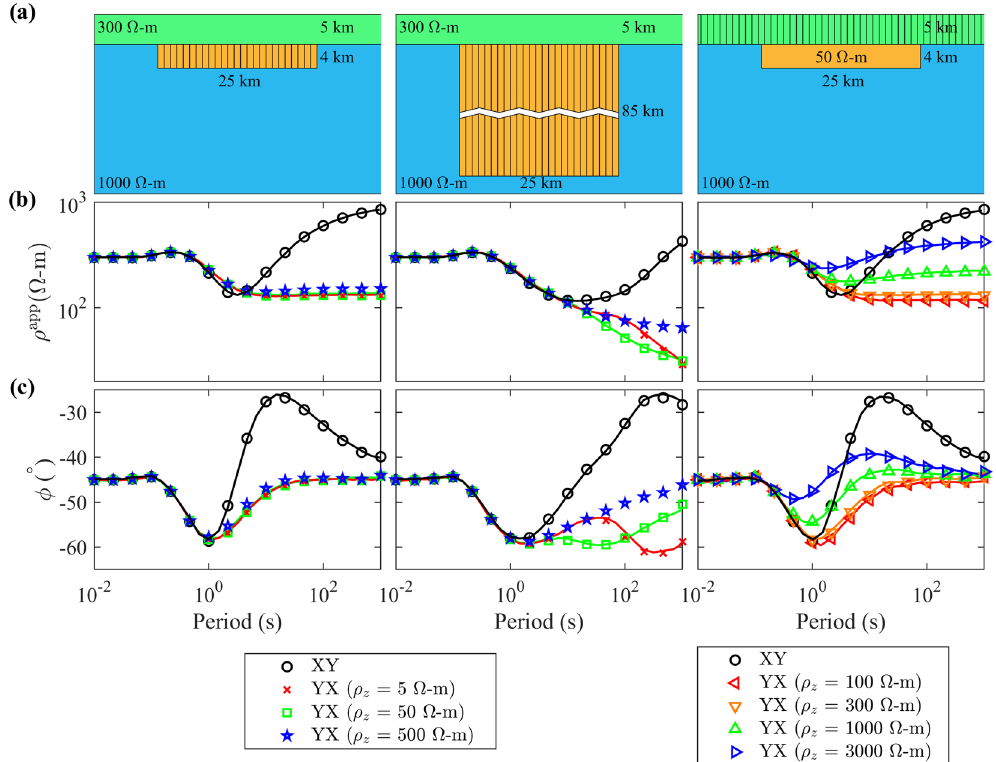
Fig. 14 a The three 2‑D synthetic models of Pek et al. (2008), b their corresponding apparent resistivities and c phases. Solid lines are responses digitized from Fig. 3 of Marti (2014). Colored symbols are our calculations for various vertical resistivity